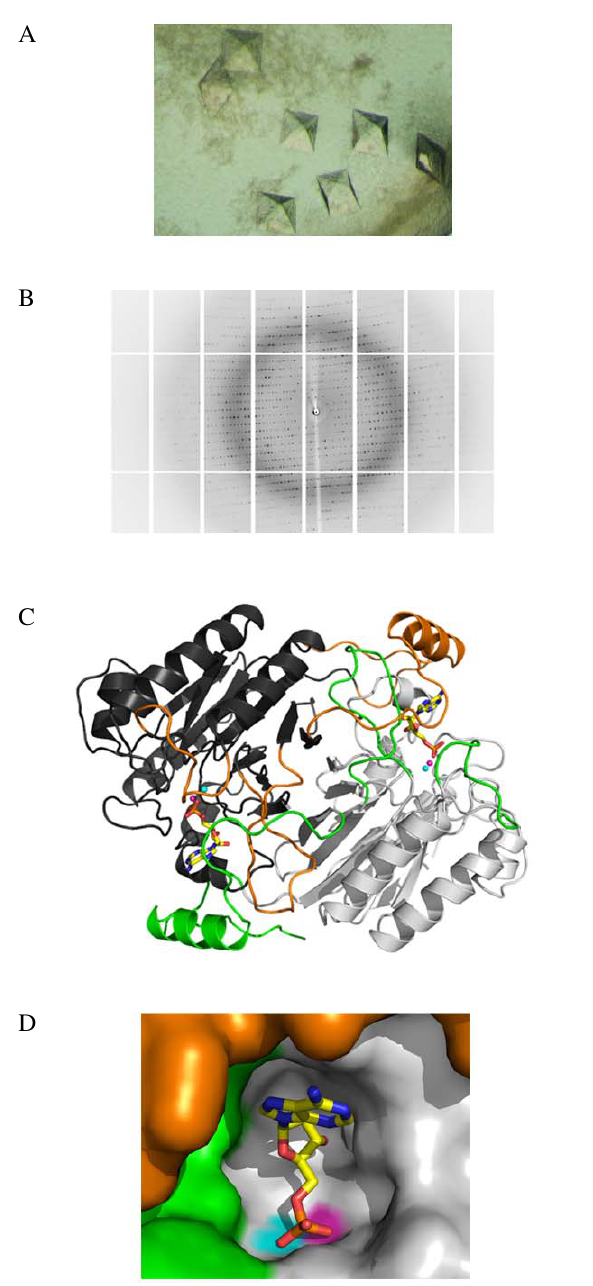
Figure 7 . From crystals to structure: (A) Protein crystals. (B) X-ray diffraction data obtained at the synchrotron X-ray source. (C) Cry- stal structures often reveal details of protein complex with smaller ligands. Here, structure of metallophosphodiesterase Rv0805 ho- modimer from Mycobacterium tuberculosis in complex with AMP is shown. 102 (D) the same as in (C), showing the surface of the acti- ve site and the bound AMP molecule in